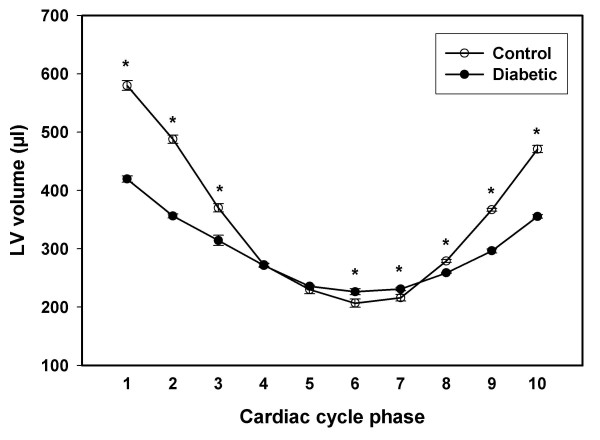
Left ventricular (LV) volume profiles of control and diabetic rats obtained from MRI reconstruction of LV slices collected throughout the complete cardiac cycle Graphical representation of LV volumes corresponding to ten equally incremented phases of the rat cardiac cycle is provided. The LV volumes for control (open circles) and diabetic (filled circles) rats were computed from the corresponding MRI scans as described in methods. End-diastole and end-systole correspond to phase 1 and phase 6, respectively, in both the control and diabetic group. LV volumes in all but phases 4 and 5 were significantly different (*, P < 0.05) between groups. Note that the actual cardiac cycle duration was 216.7 ± 28.7 ms in control and 242.5 ± 15.0 ms in diabetic rats, with an insignificant difference (P > 0.05). Hence the cardiac cycle was divided into phases 1 through 10 as discussed in the methods section.